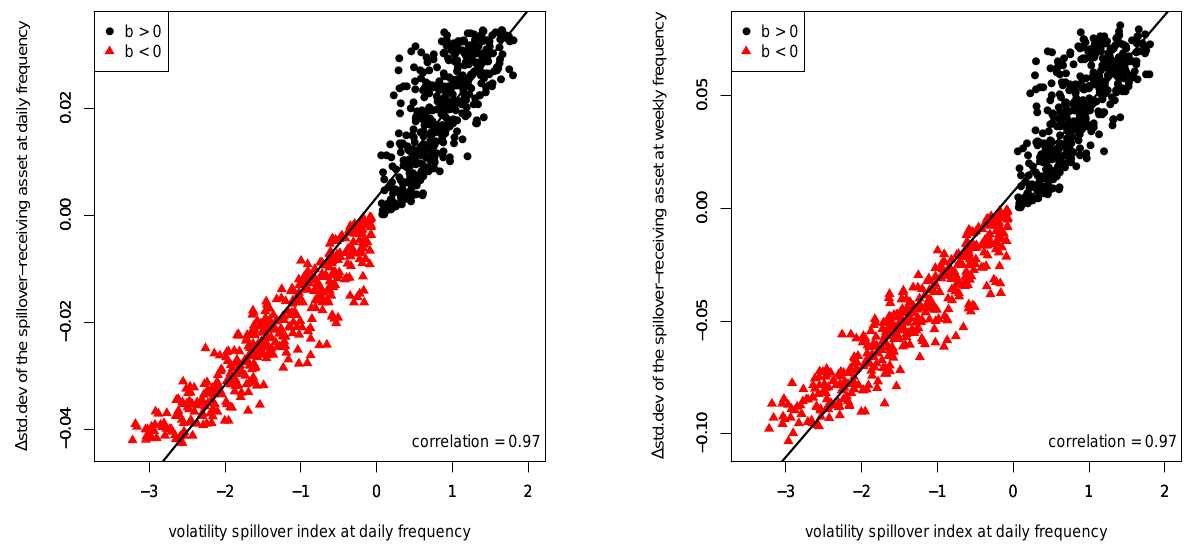
Figure 10. Simulation results with the Diebold–Yilmaz spillover index. This figure presents the effects of daily spillovers (measured by the Diebold–Yilmaz spillover index) on assets’ characteristic at daily and weekly frequencies. We use “daily” and “weekly” for the illustration purpose; the results also apply to other relative “high” and “low”